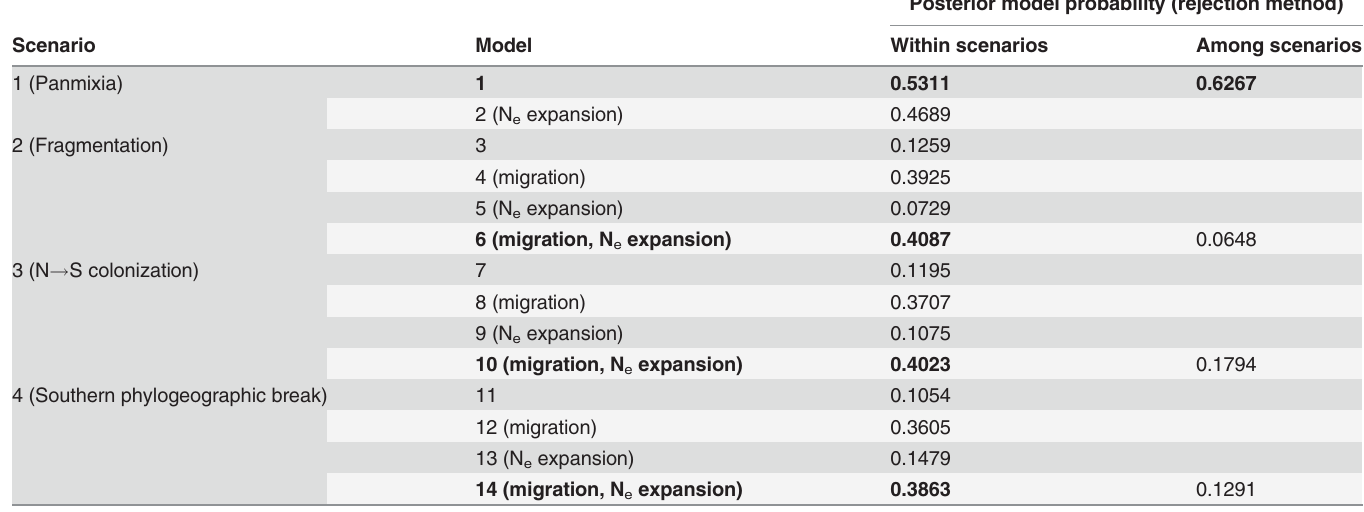
Table 4. Model selection within and among scenarios based on rejection